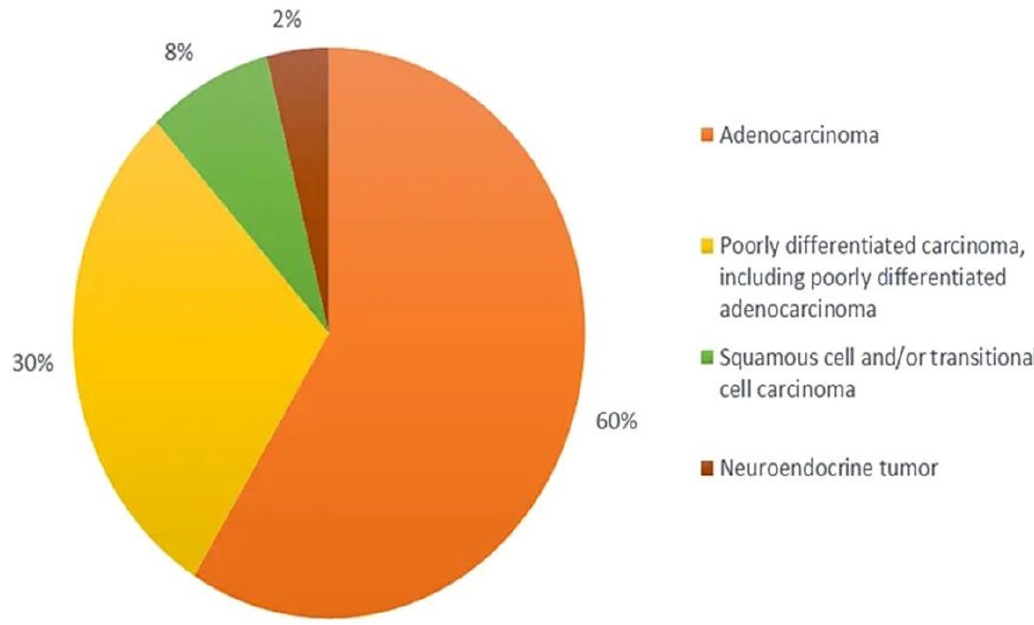
Figure 1. Histological categorisation of CUP.